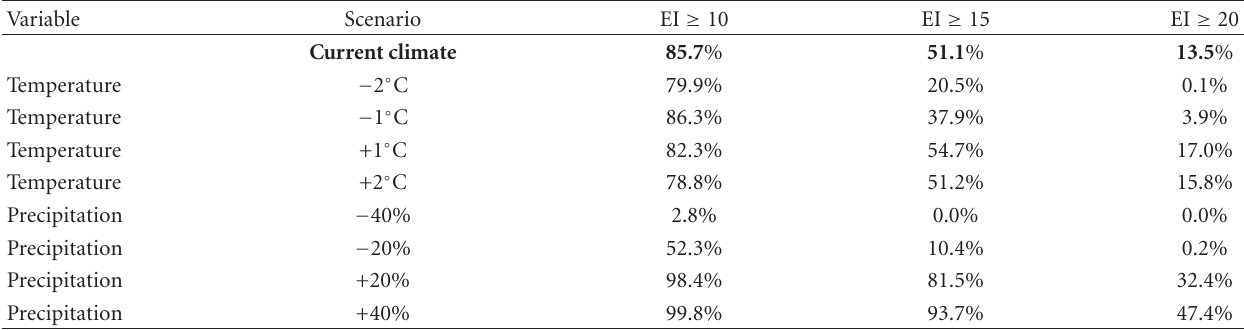
Figure 3: Predicted Ecoclimatic Index (EI) values with precipitation 40% less (a) and 40% greater (b) than current climate. Dark blue: lakes; Light blue: “Unfavourable” (EI = 0–5); Green: “Marginal” (EI = 5–10); Yellow: “Suitable” (EI = 10–15); Tan: “Favourable” (EI = 15–20); Red: “Very Favourable” (EI > 20). Table 3: E ff ect of changes in temperature and precipitation from current climate on Ecoclimatic Index (EI) values for Sitona lineatus across all locations within the Prairie Ecosystem ( n = 3420 grid cells). The values are expressed as a percentage of total geographic area.